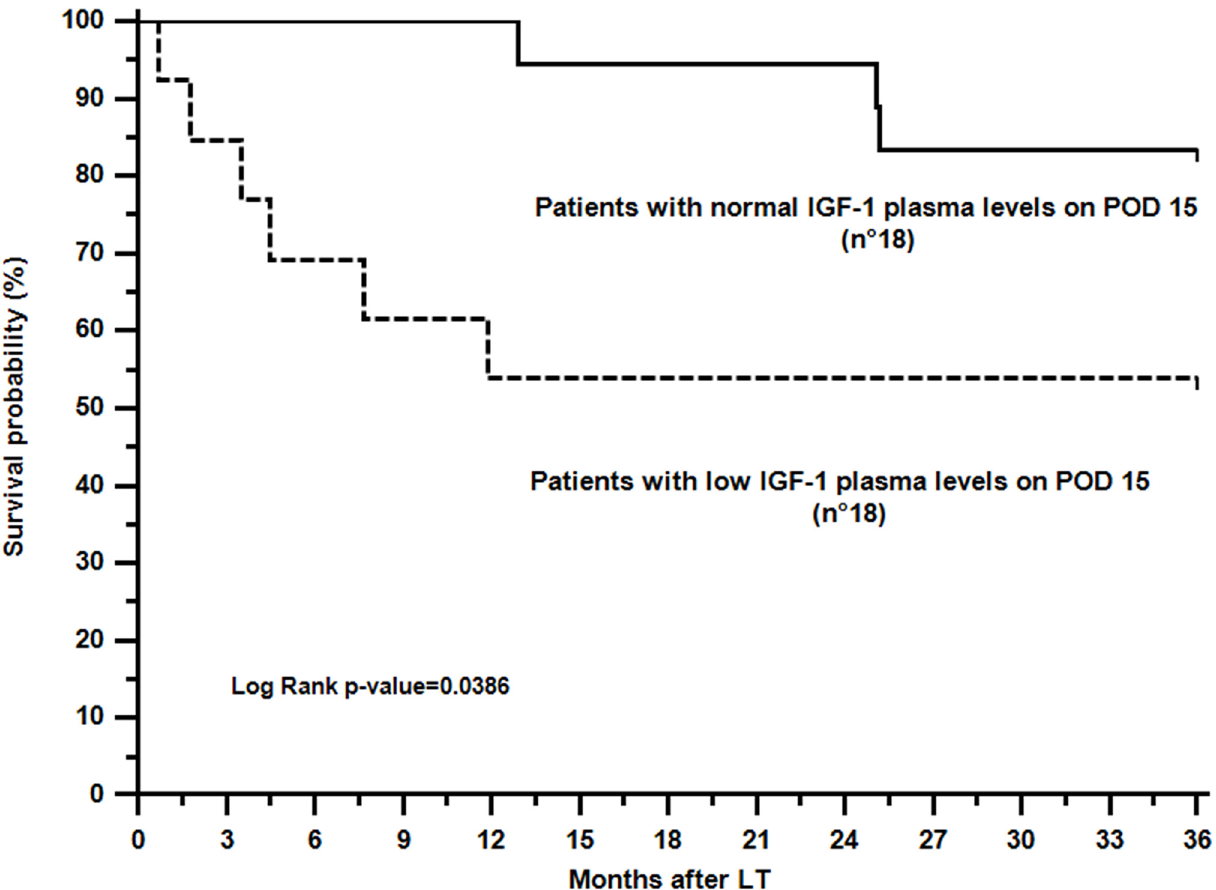
Fig 3. Actual 3-year survival analysis in patients showing normal (solid line) or low (dotted line) IGF-1 plasma levels on postoperative day 15. Survival differences were investigated by the Log Rank test. Abbreviations: IGF-1, insulin-like growth factor 1; LT, liver transplantation; POD, postoperative